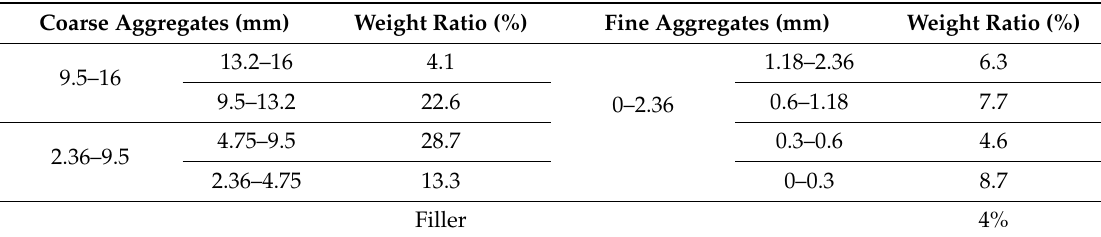
Table 7. Aggregate composite gradation of AC 13 asphalt